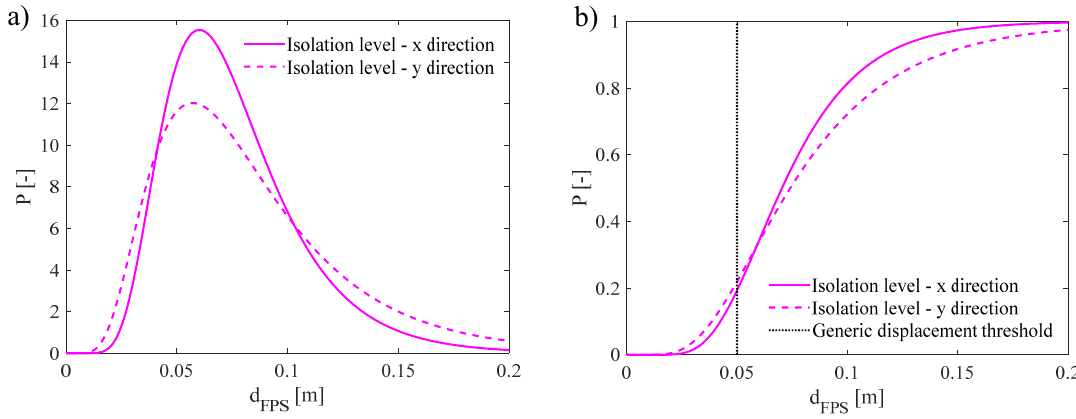
Figure 14. Lognormal monovariate PDFs and CDFs for horizontal relative displacement of FP device in X and Y direction with reference to the isolation level. ( a ) PDFs. ( b ) CDFs.